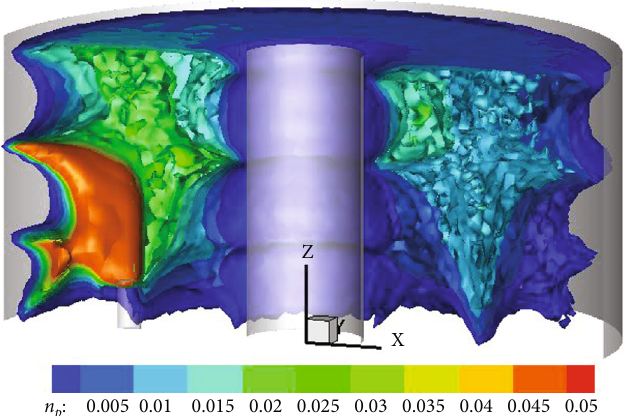
Figure 15: Distribution of primary electron density with 6 times the initial magnetic fi eld strength.